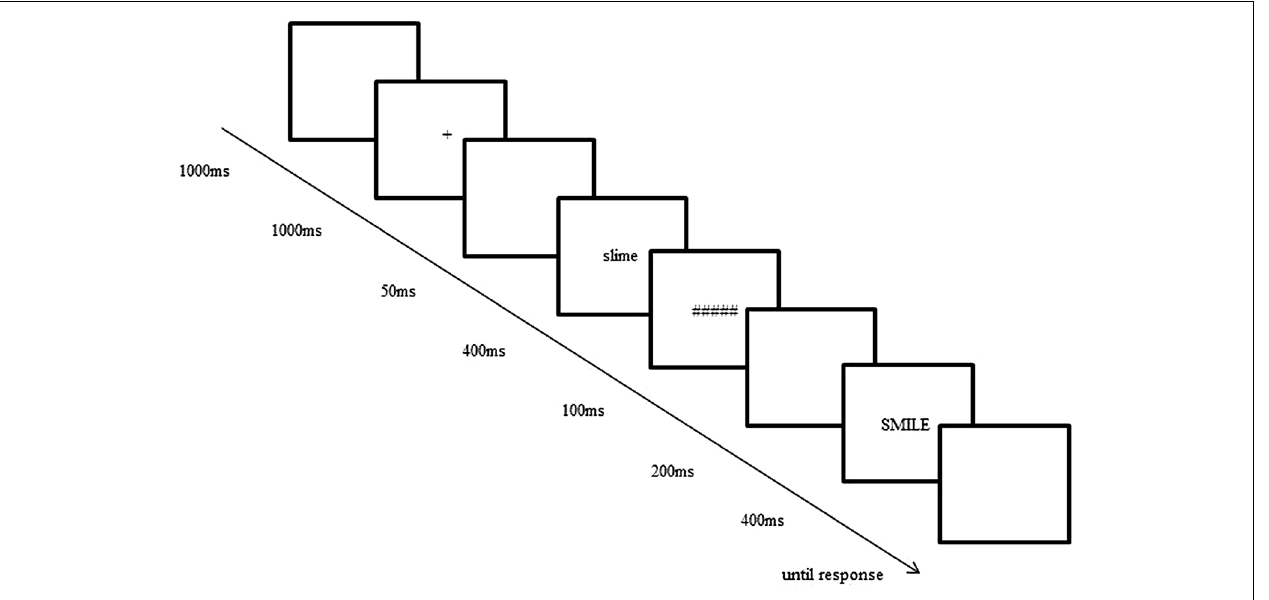
FIGURE 2 | Schematic of a single same-different decision